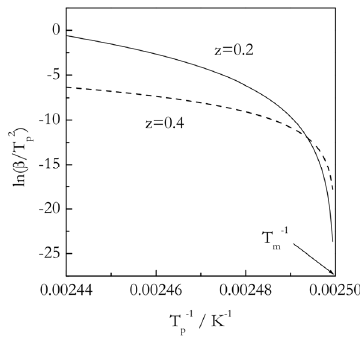
Figure 9. Kissinger plots for a melting process with T m = 400 K and superheating up to 10 K, for the z values 0.2 and 0.4. Adapted from Vyazovkin [67]. Copyright 2018 ACS.